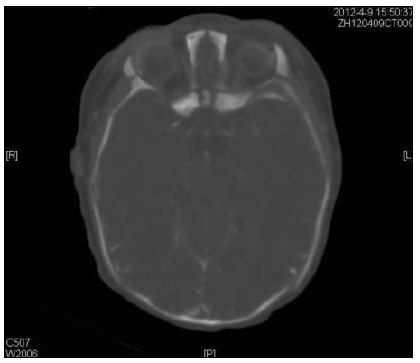
Figure 2: CT scan showing microphthalmia.